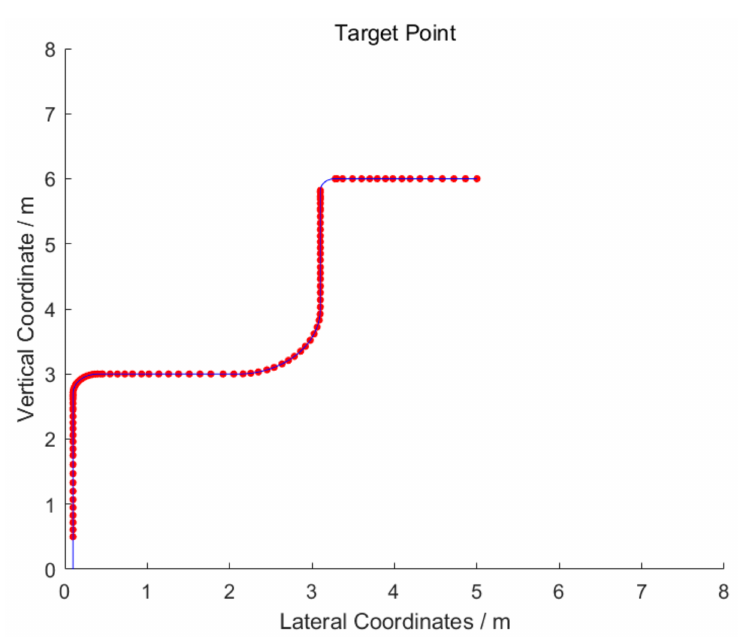
Figure 16. Distribution map of target